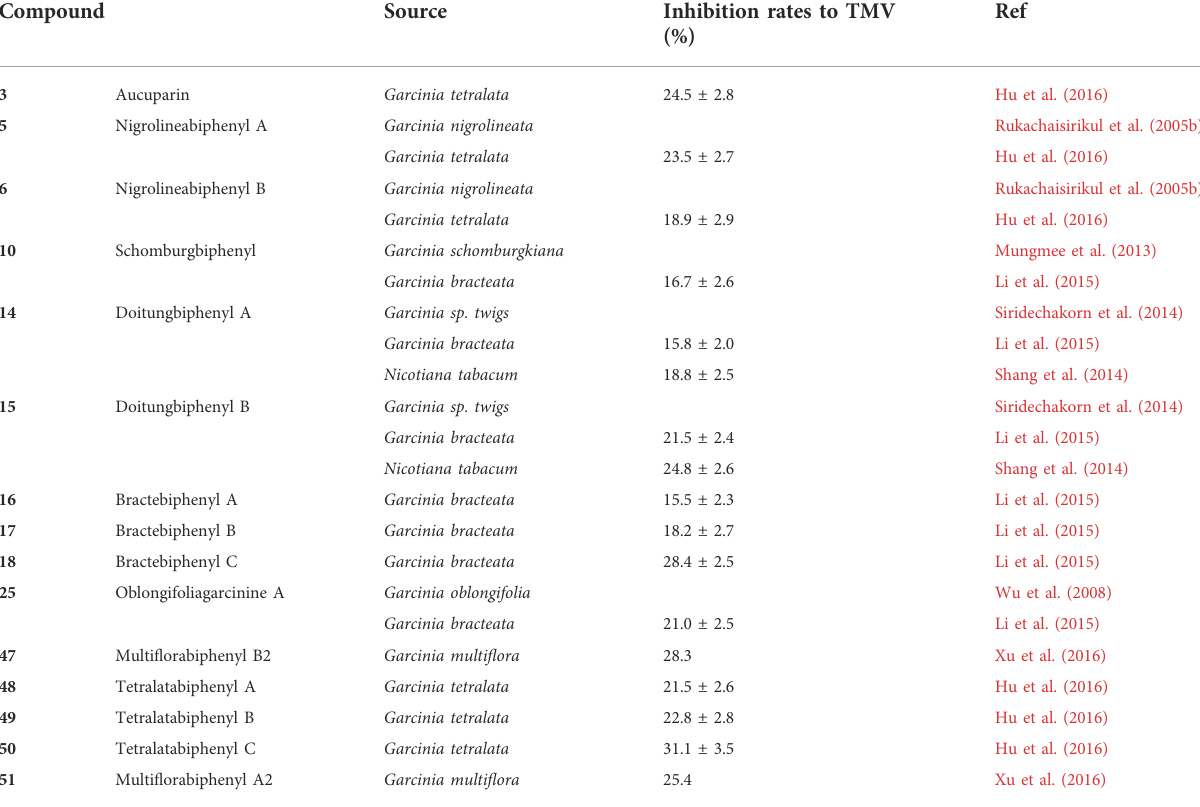
TABLE 3 Biphenyls from Clusiaceae and associated anti-tobacco mosaic virus (anti-TMV) activity at the concentration of 20 μ